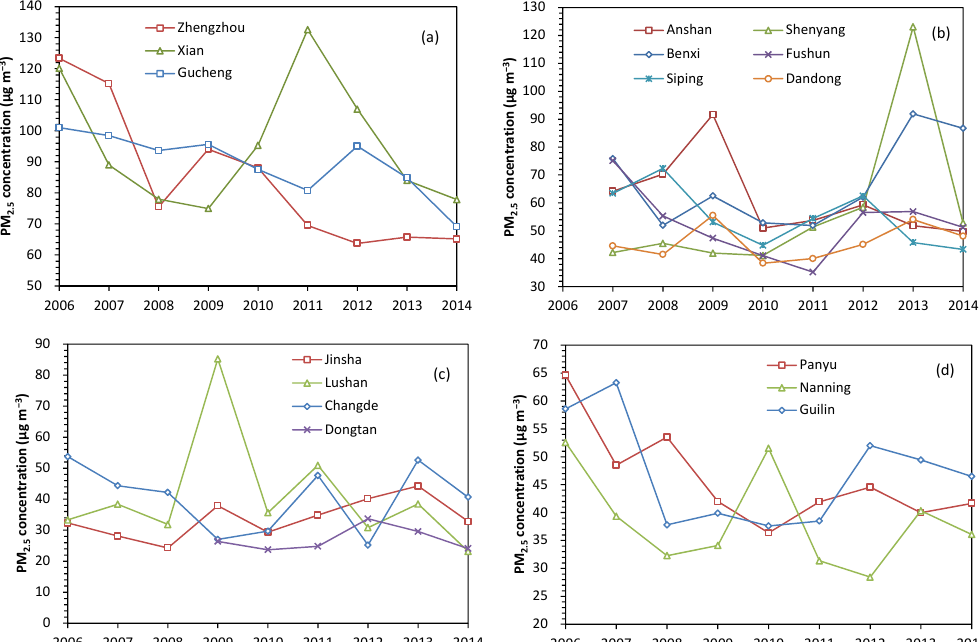
Figure 5. Interannual variations of PM 2 . 5 concentrations at the stations (a) on the HBP and Guanzhong Plain, (b) in northeast China, (c) along the middle and lower reaches of the Yangtze River and (d) in southern China.